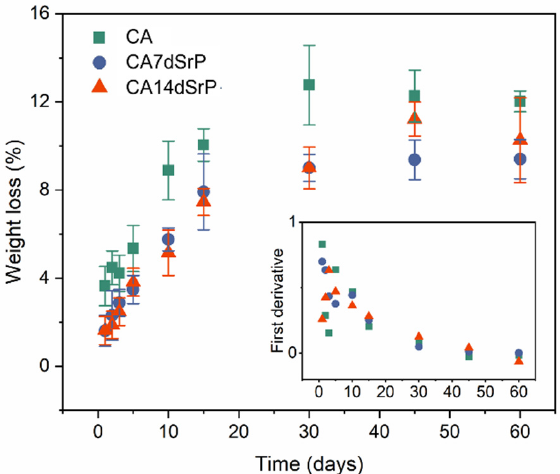
Figure 7. Degradation behavior during 60 days in PBS solution of the CA, CA7dSrP, and